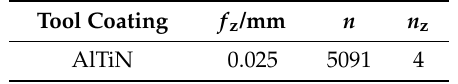
Table 3. Milling parameters of the investigated surface morphologies.